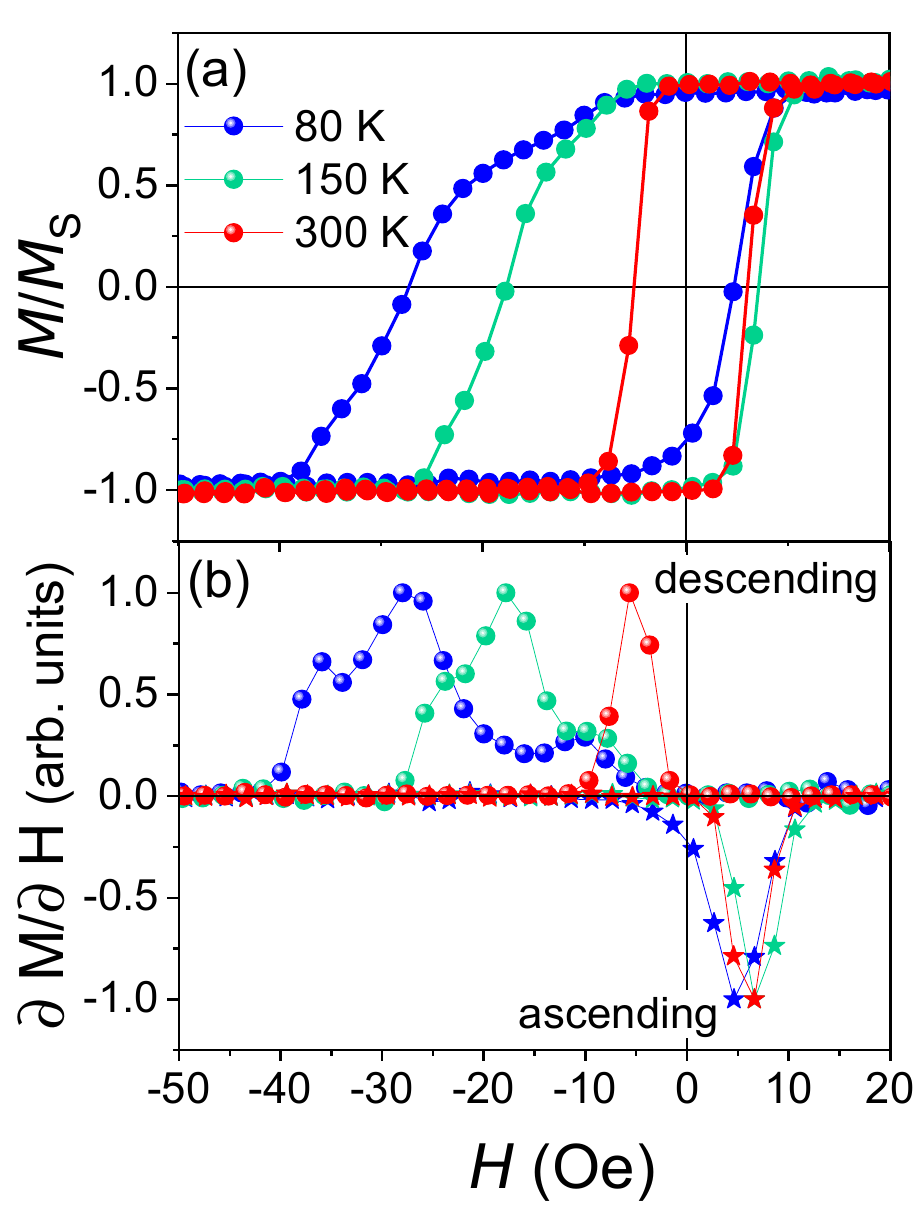
Figure 11. Hysteresis loops ( a ), measured at 80 K, 150 K, and 300 K, for the samples NiFe (40 nm)/FeMn (20 nm), deposited at the substrate temperature of 600 ◦ C, and corresponding switching field distributions ( b ).